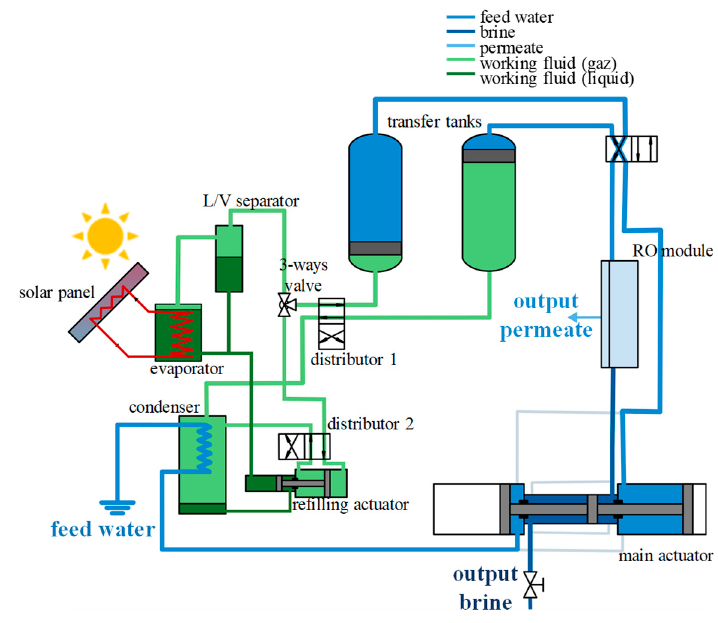
Figure 1. Global diagram of the thermo-hydraulic desalination process.